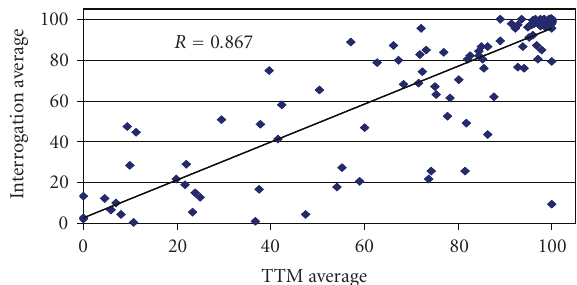
Figure 1: Number of TTMs versus Percentage RVP from interro- gation. Correlation coe ffi cient is for entire group. Values analyzed were either < 20% or > 80%, which fell closer to the line of identity. (RVP = right ventricular pacing. TTMs = transtelephonic monitor reports.) Table 1: TTM validation for % right ventricular pacing. Number of TTM values Number of patients Correlation